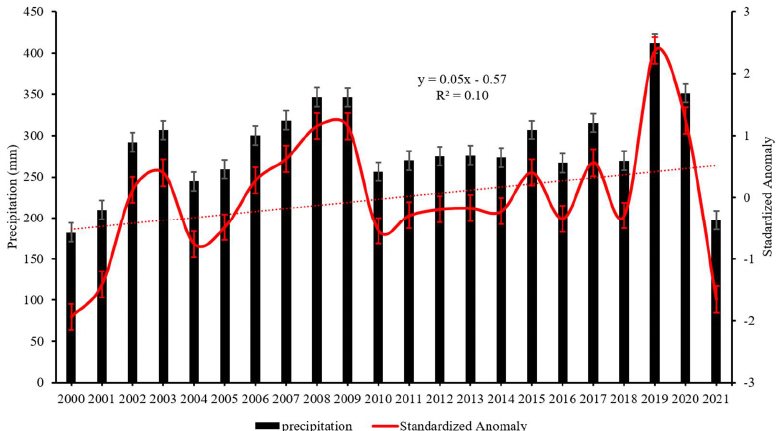
Figure 9. Time series of yearly precipitation sums and standardized precipitation anomaly in Afghanistan in the period 2000–2021.